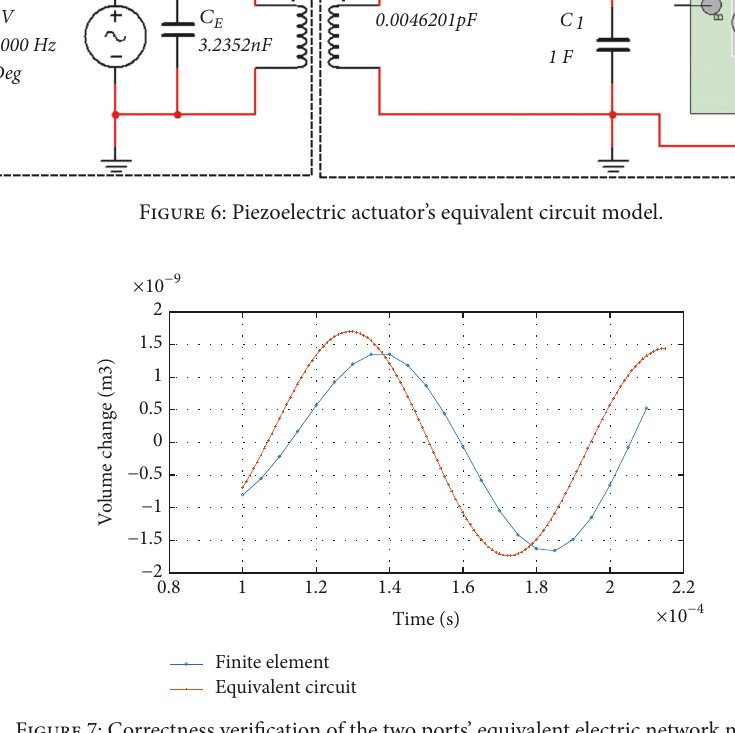
Figure 7: Correctness verification of the two ports’ equivalent electric network model.